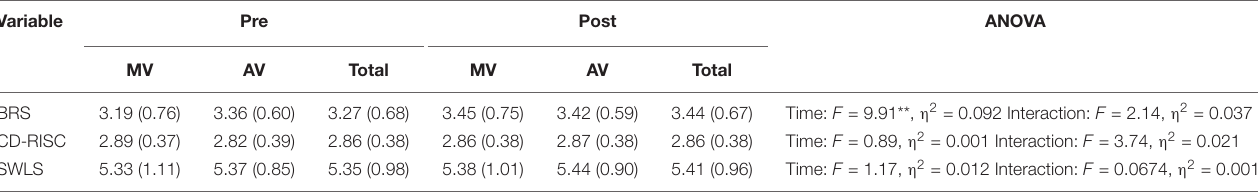
TABLE 3 | Results of pre-post measures: means, standard deviations, and ANOVA. Variable Pre Post ANOVA